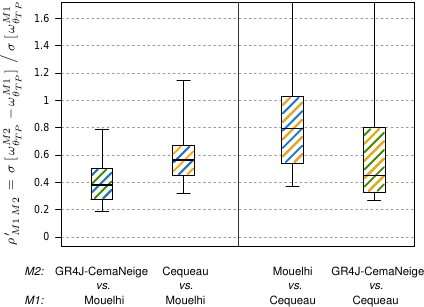
Fig. 8. Behavioural similarities observed between different models in terms of 10-yr mean flow volume errors. Calibrations over the full record (distributions over 20